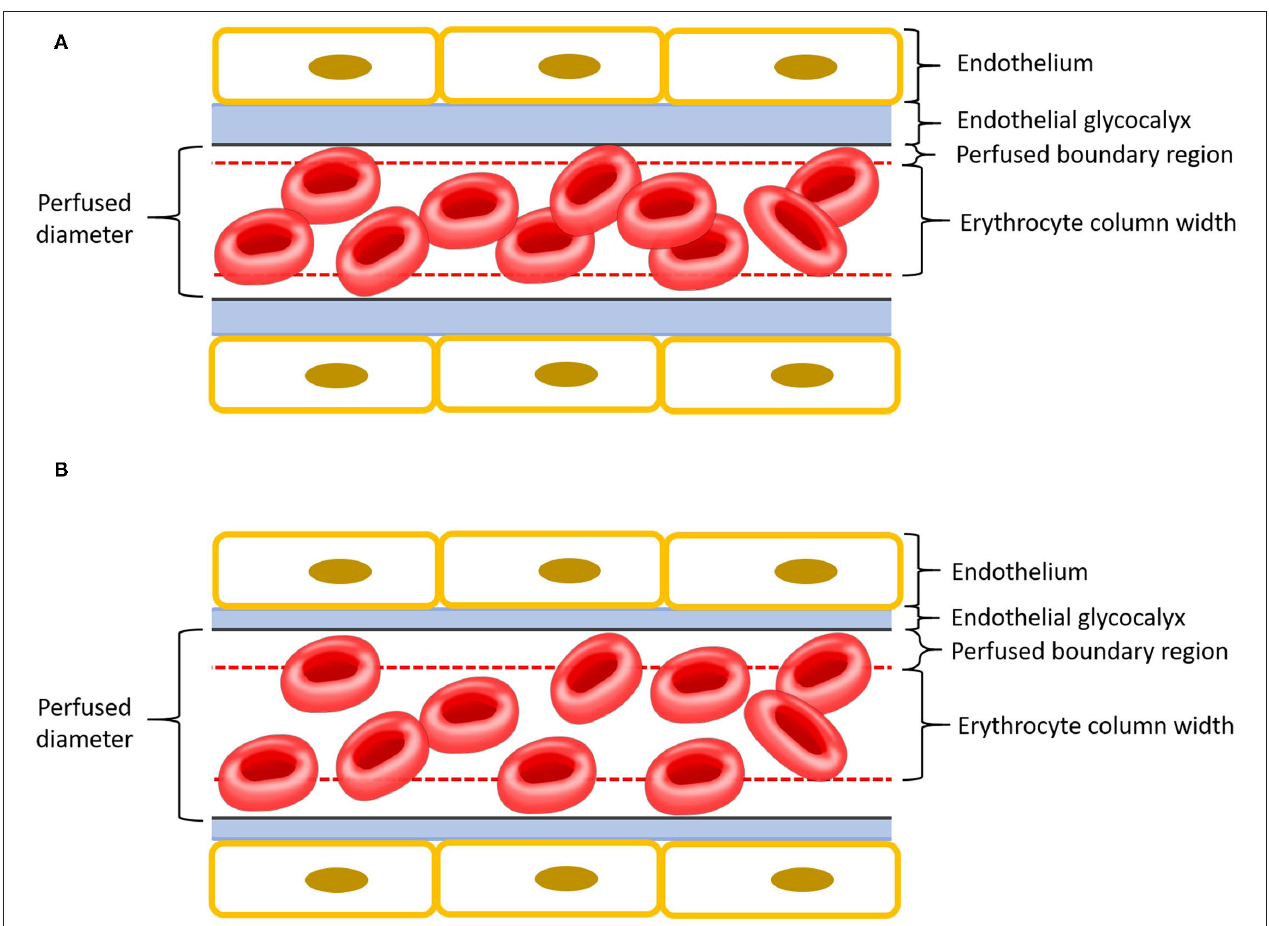
FIGURE 1 | Schematic representation of a capillary with endothelium is in yellow, endothelial glycocalyx in blue, perfused boundary region in red dashed lines, and erythrocytes in red. Please note that the different components of this cartoon are scaled for emphasis. (A) Intact endothelial glycocalyx characterized by a small perfused boundary region. (B) Damaged (thinner) endothelial glycocalyx characterized by a large perfused boundary region.